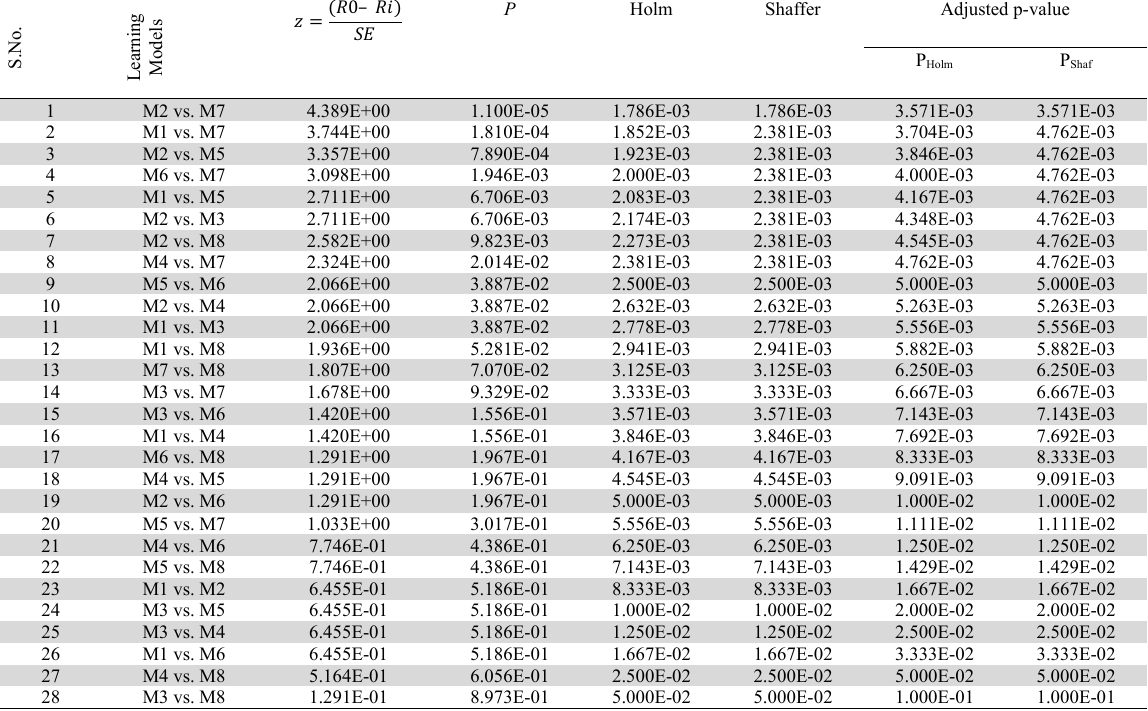
Adjusted p-value and p-value for post-hoc multiple comparisons of different models at significance level α =0.05 for inexperienced . N o S .